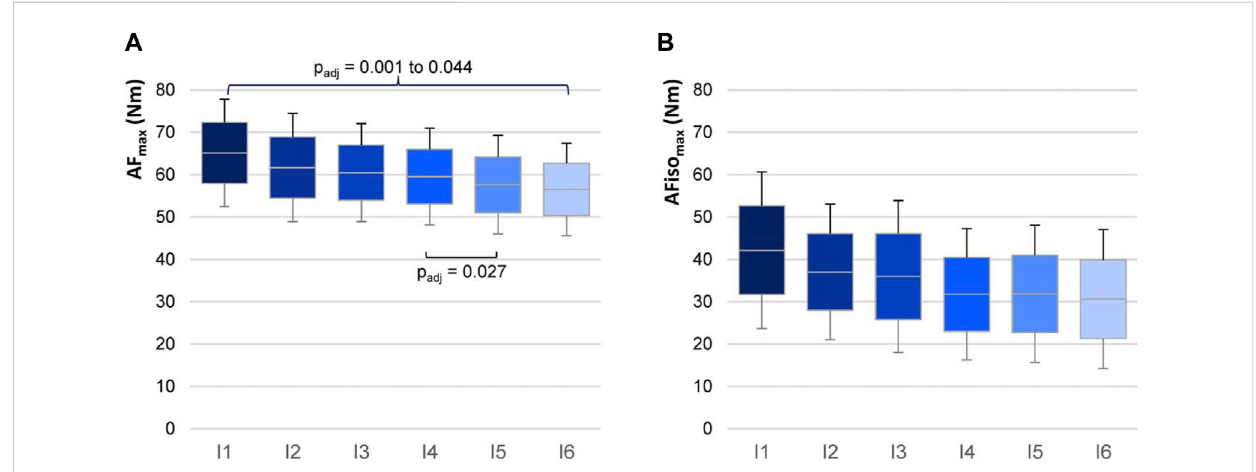
FIGURE 5 AF torques in six intervals. Arithmetic means, standard deviations (error bars), and 95% CIs of AF max (A) and AFiso max (B) regarding the six intervals (I1 – I6) are illustrated for n = 12 participants. Intervals consist of the arithmetic mean of torques for fi ve consecutive measurements each (I1 = mean of M1 to M5; ... I6 = mean of M25 to M30). Adjusted p -values (Bonferroni correction) are given for signi fi cant pairwise